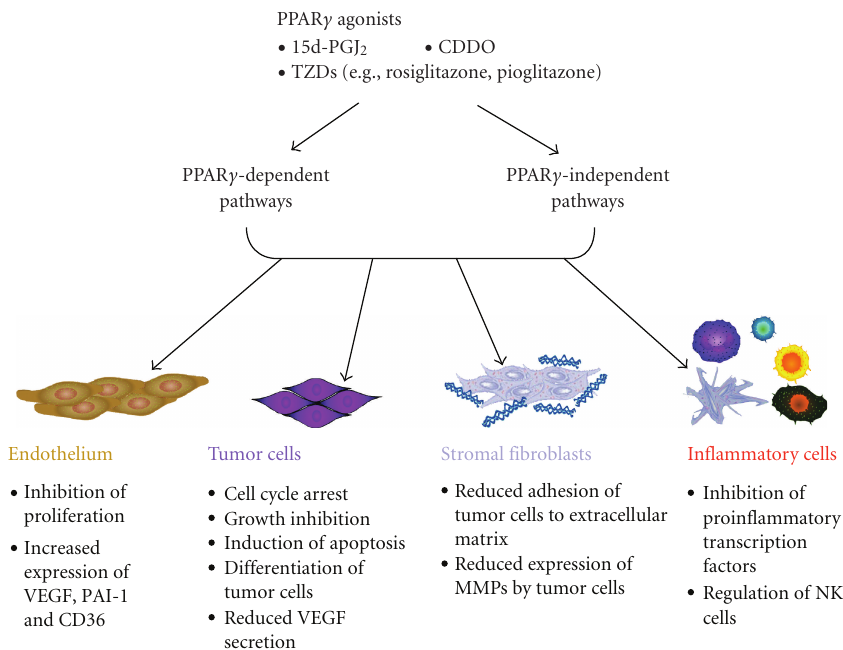
Figure 6: Direct and indirect e ff ects of PPAR γ agonists on tumor and stromal cells. “O ff -target” (PPAR γ -independent) e ff ects of PPAR γ agonists frequently occur when the agonists are used at high concentrations (much higher than needed to active PPAR γ by ligand binding) and in response to electrophilic PPAR γ agonists such as 15d-PGJ 2 and CDDO, which can promote covalent bond formation with cellular proteins in a redox-sensitive manner to modulate signal transduction pathways. PPAR γ agonists have been shown to a ff ect almost every stage of tumor progression from inhibition of uncontrolled tumor growth, induction of apoptosis, inhibition of tumor cell adhesion and invasion through stromal compartments into or out of the blood stream, and inhibition of tumor-associated angiogenesis. PPAR γ agonists induce expression of tumor-inhibiting molecules such as CD36, the EC receptor for TSP-1, as well as promote the di ff erentiation of tumor cells, which tends to reduce their invasive and metastatic capabilities. The schematic in this figure was adapted from